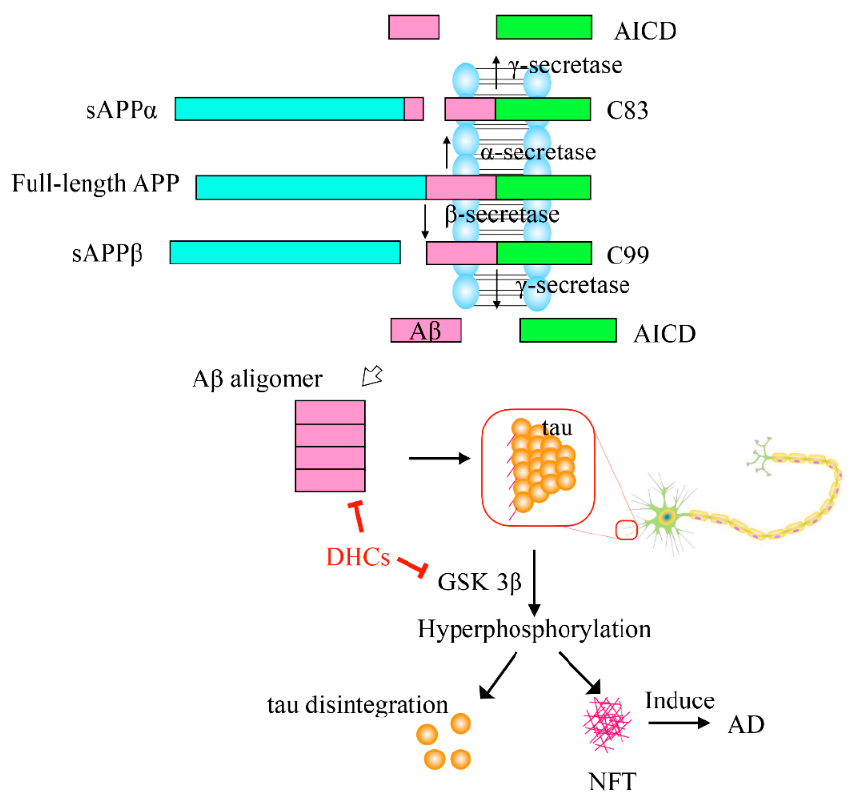
Figure 3. Directly neuroprotective effects of the DHCs. APP, amyloid precursor protein; sAPP α , soluble α -APP fragment; C83, 83-amino-acid membrane-bound C-terminal fragment; AICD, APP intracellular domain; sAPP β , soluble β -APP; C99, 99-amino-acid C-terminal; A β , amyloid β -protein; GSK 3 β , glycogen synthase kinase 3 β ; NFT, Nerve Fiver Tangles. Arrow ( → ) indicates activation, and the blunt arrow (– | ) indicates inhibition.